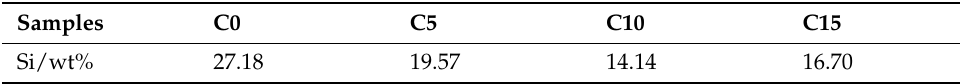
Table 2. The residual silicon content of composites.